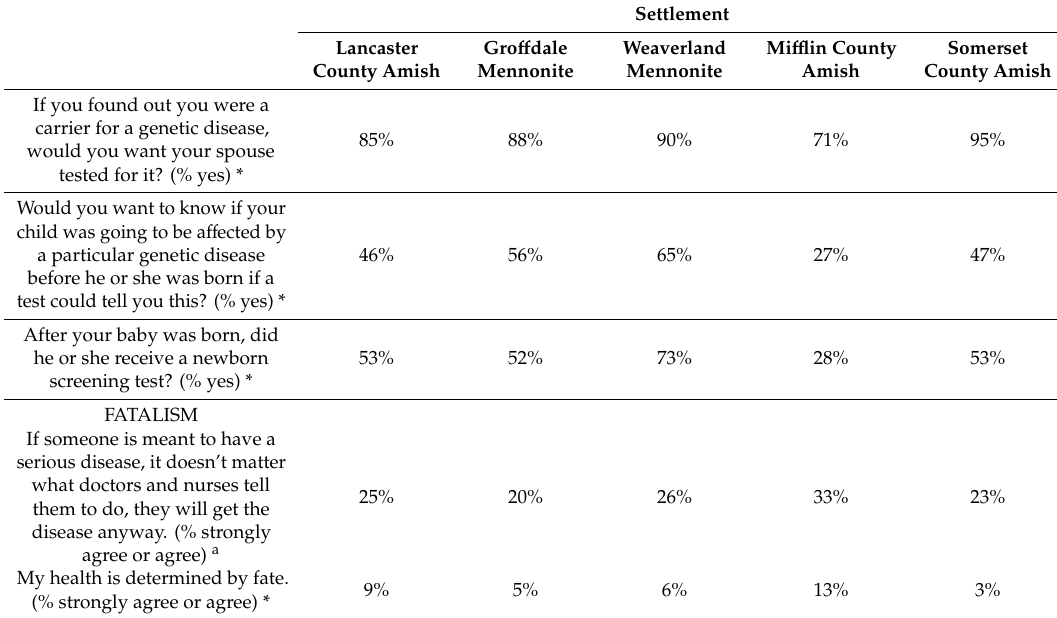
Table 6. Attitudes towards genetic testing and fatalism in 5 Pennsylvania Plain communities.